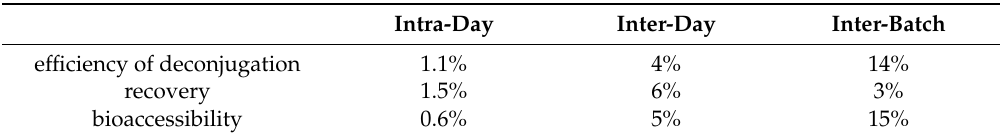
Table 1. Coefficient of variation (%) for a triple execution of the assay on one day (intra-day), on three days (inter-day) and using three different lots of brush border membrane (inter-batch) with spinach as the model matrix.